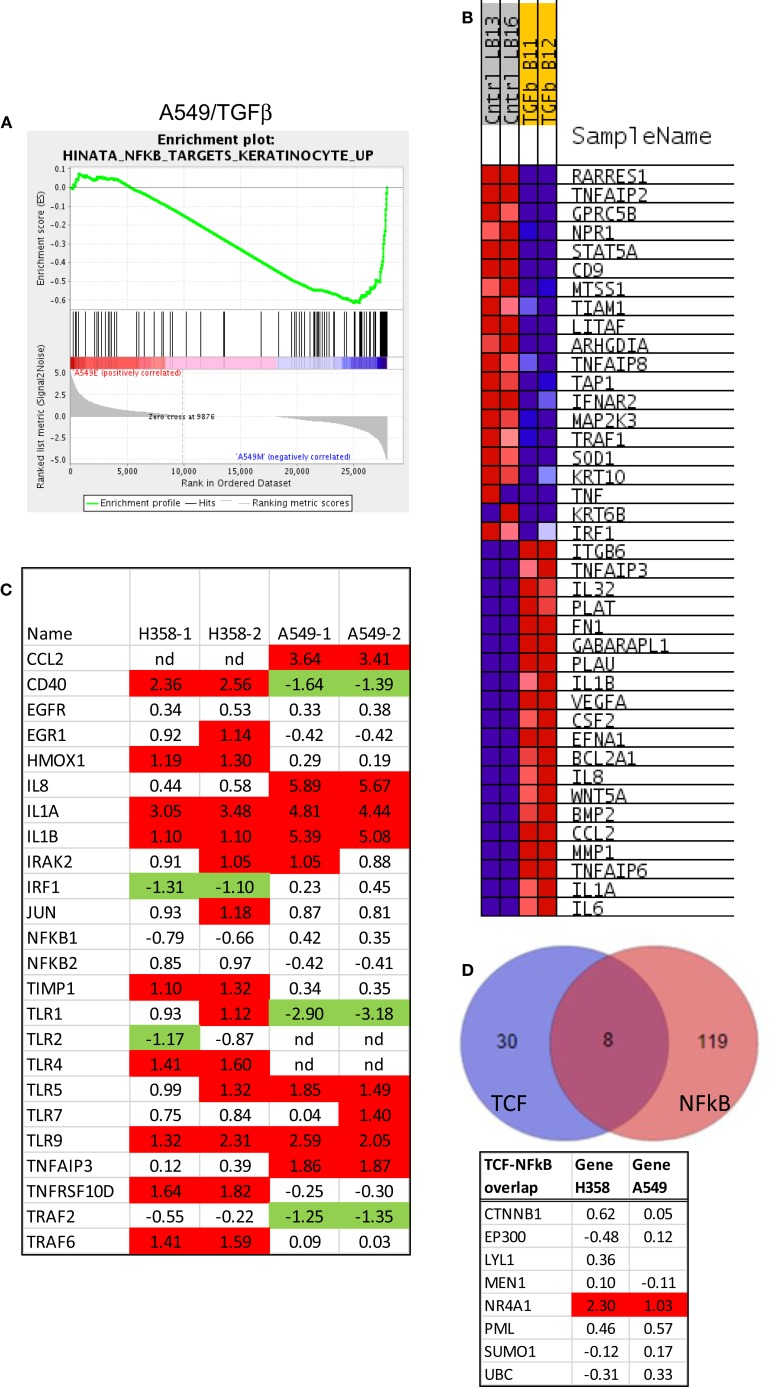
Activation of the NFκB pathway in mesenchymal H358. (A) Correlation of A549 EMT regulated genes with the NFκB signature from NFκB and RELA over-expression in keratinocytes (52). Normalized enrichment score (NES) was −1.85, nominal p-value <0.001, FDR q-value 0.01. (B) The top 20 positively and negatively correlated genes were identified and heat mapped for A549, as defined in Figure 4. (C) Heat map of RNA abundance of NFκB signaling components and target genes in H358 and A549 isogenic models (mesenchymal/epithelial; log2). (D) Protein–protein overlaps between TCF4 and NFκB protein interaction datasets from BioGrid, showing NR4A1 as a common physical node between the two pathways.